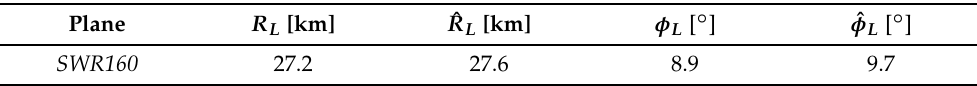
Table 2. Distance and azimuth of the SWR160 plane’s location in relation to the LOFAR